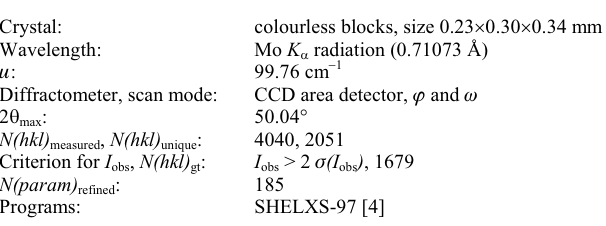
Table 1. Data collection and handling.